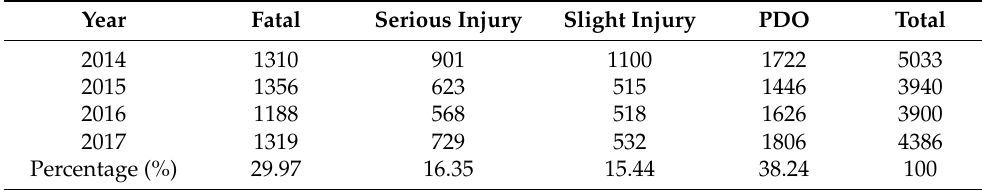
Table 2. A four-year number of traffic crashes reported in their respective severity